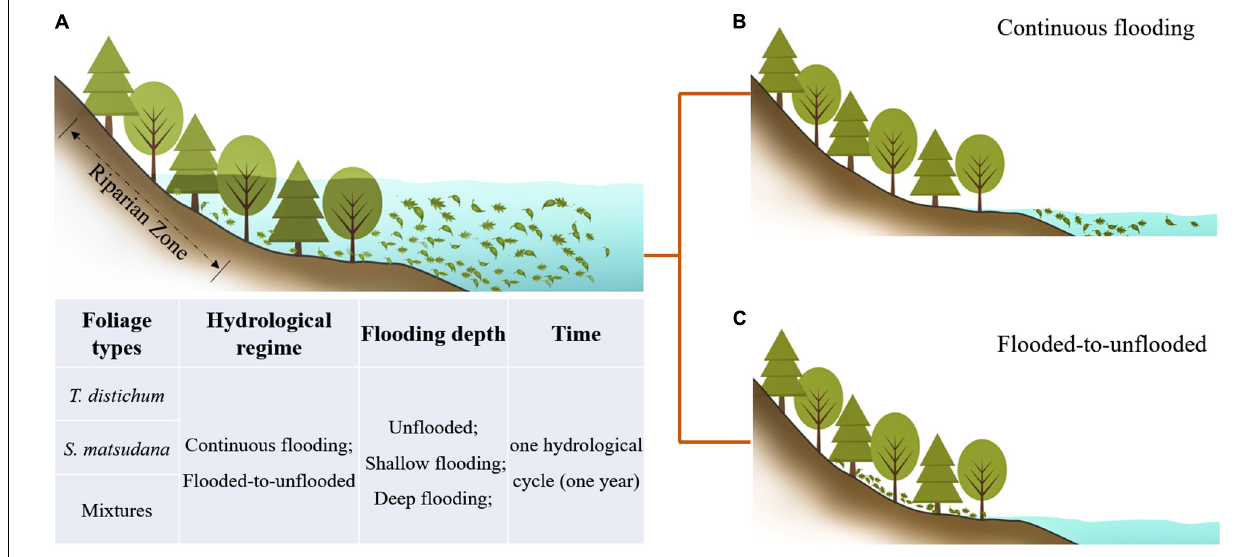
FIGURE 1 | The decomposition process of the leaves of dominant tree species under hydrological regimes in the riparian zone. (A) The water level rises, and the leaves undergo flooded decomposition. (B,C) The water level drops, and the leaves continue to undergo flooded decomposition or unflooded